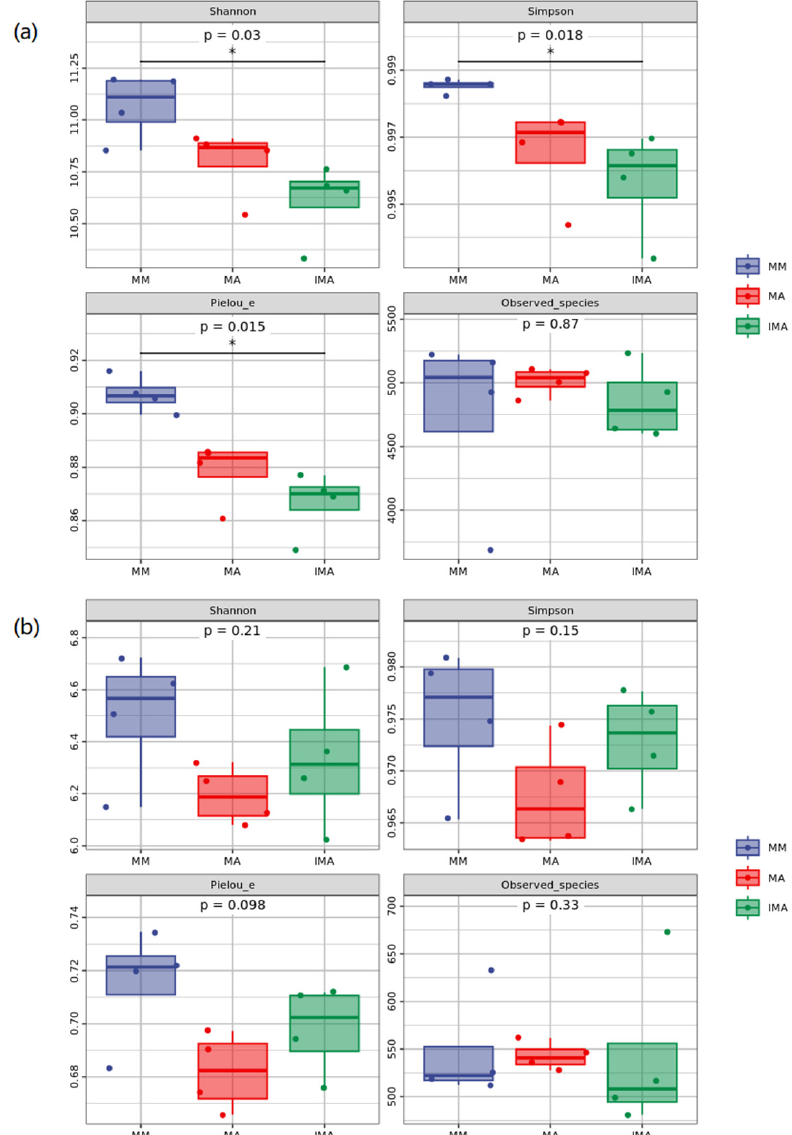
Figure 5. Alpha diversity of soil microorganisms under different treatments. ( a ): Analysis of alpha diversity of soil bacterial community; ( b ): Analysis of alpha diversity of soil fungal community. * Correlation is significant at the 0.05 level. MM: Morus alba ; MA: Medicago sativa ; IMA: Morus alba – Medicago sativa .